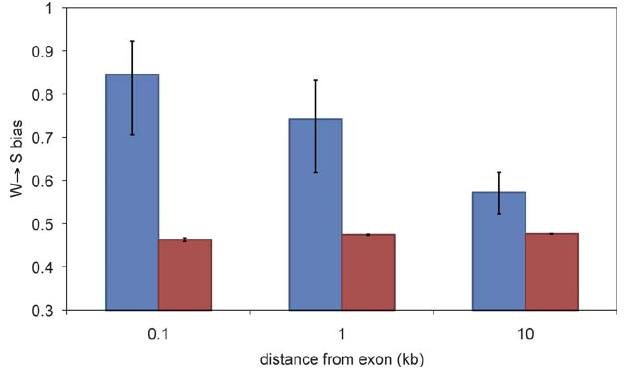
Figure 3. Patterns of Base Substitution in Flanking Regions Average W ! S bias of base substitution patterns in noncoding regions surrounding the top 20 accelerated exons (blue bars) compared with W ! S bias in noncoding regions surrounding all exons in the dataset (red bars). 95% confidence intervals were estimated by bootstrapping with